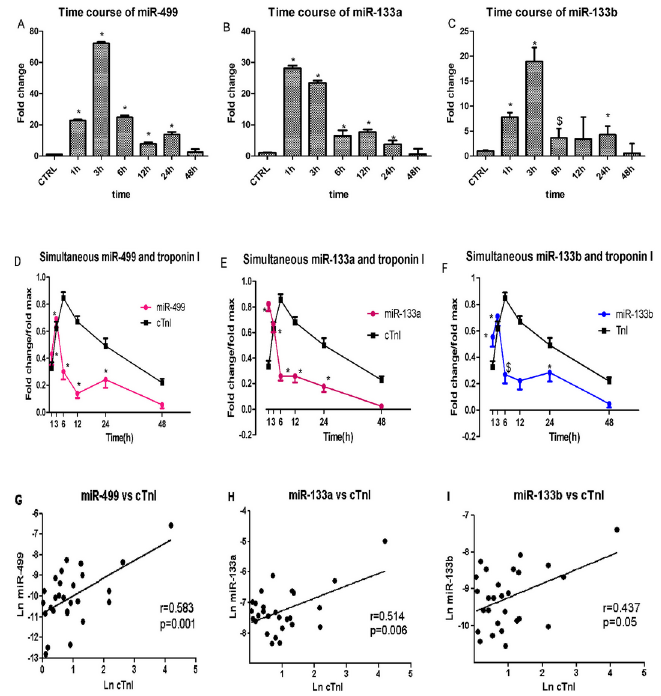
Figure 2. Plasma miR and troponin I levels from 29 patients undergoing on-pump CABG (Step I). (A–C) Mean concentrations of circulating miRs expressed as the fold increase (2 2 DD Ct scale) relative to those at the preoperative time point. On average, miR-499, miR-133a, and miR- 133b exhibited a 20- to 70-fold increase in plasma samples collected 1 h and 3 h after declamping, respectively. At 48 h after declamping, the values were back to levels comparable to those in the preoperativecontrol. (D–F) Comparison of miRs and cTnI levels in thesame plasmasamples showing that miR-499, miR-133a and miR-133b peaked earlier than cTnI. (*P , 0.01; $ P , 0.05 vs. control) (G–I) Correlations between the maximum levels of miRs and cTnI. MiR-499 (G), miR-133a (H) and miR-133b (I) correlated significantly with cTnI levels (respectively P , 0.001; P , 0.01 and P ,